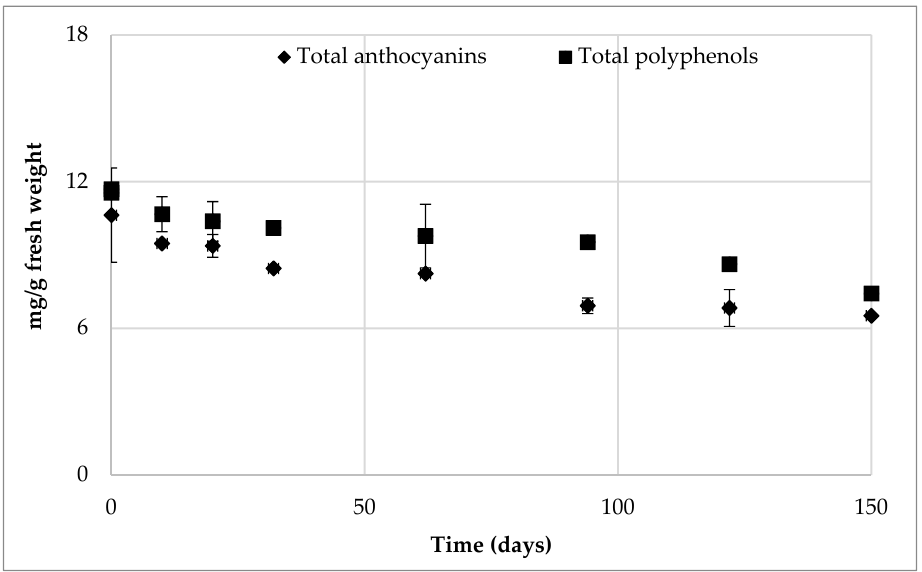
Figure 2. Total polyphenols and anthocyanins in HPP-treated sour cherries during refrigerated stor- age.